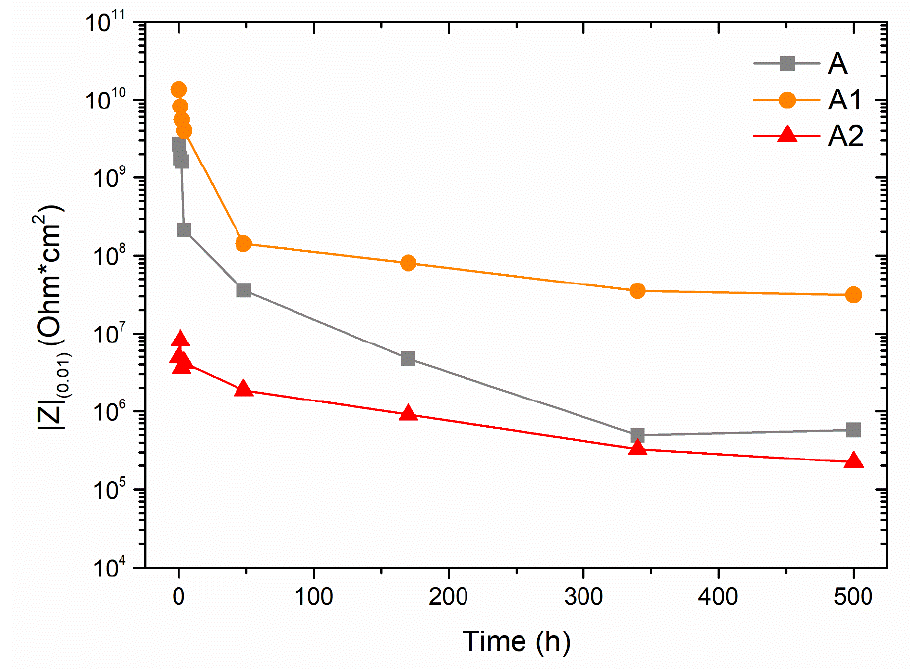
Figure 9. Bode impedance modulus |Z| (0.01) evolution with time.